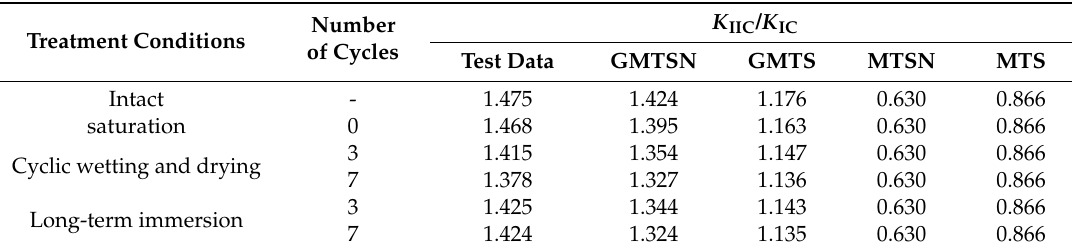
Table 3. The theoretical and experimental values of K IIC / K IC for sandstone under different treatment conditions. GMTSN—generalized maximum tangential strain; GMTS—generalized maximum tangential stress; MTSN—maximum tangential strain; MTS—maximum tangential stress. Treatment